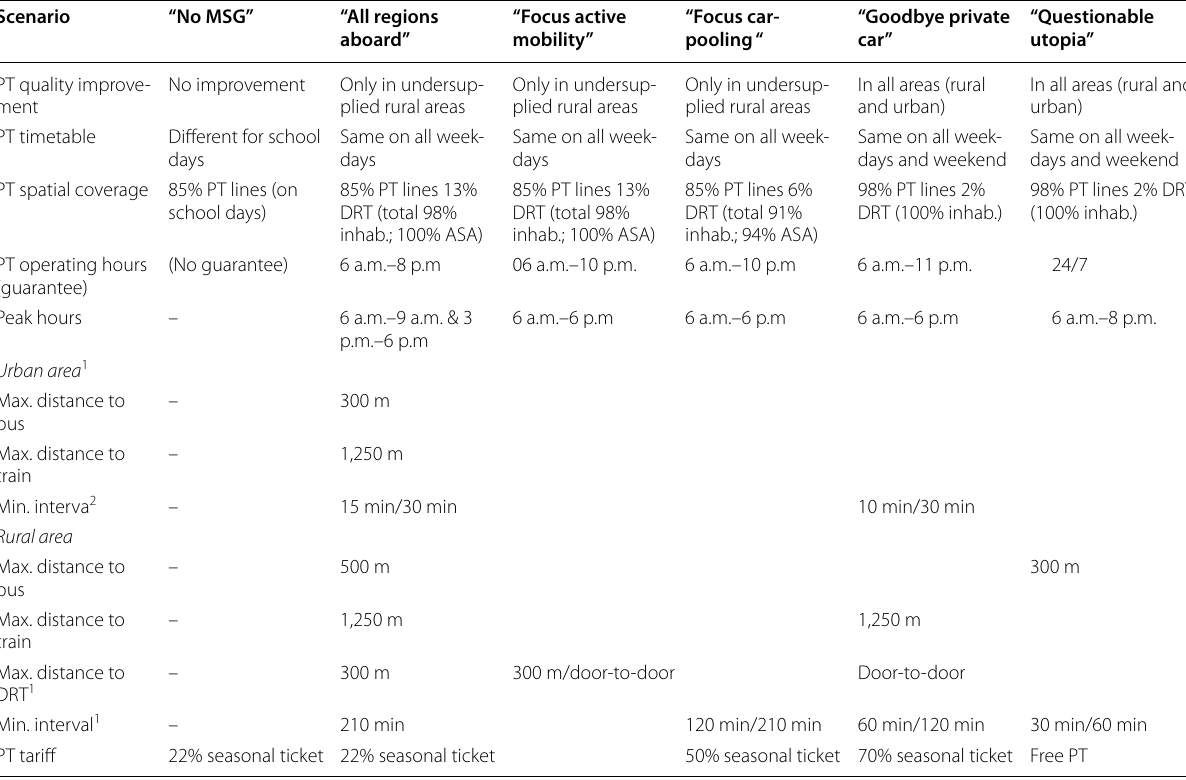
1 Classification according to urban-rural-typology of Statistik Austria https:// www. stati stik. at/ wcm/ idc/ idcplg? IdcSe rvice (Table 1); no DRT in urban areas 2 Peak